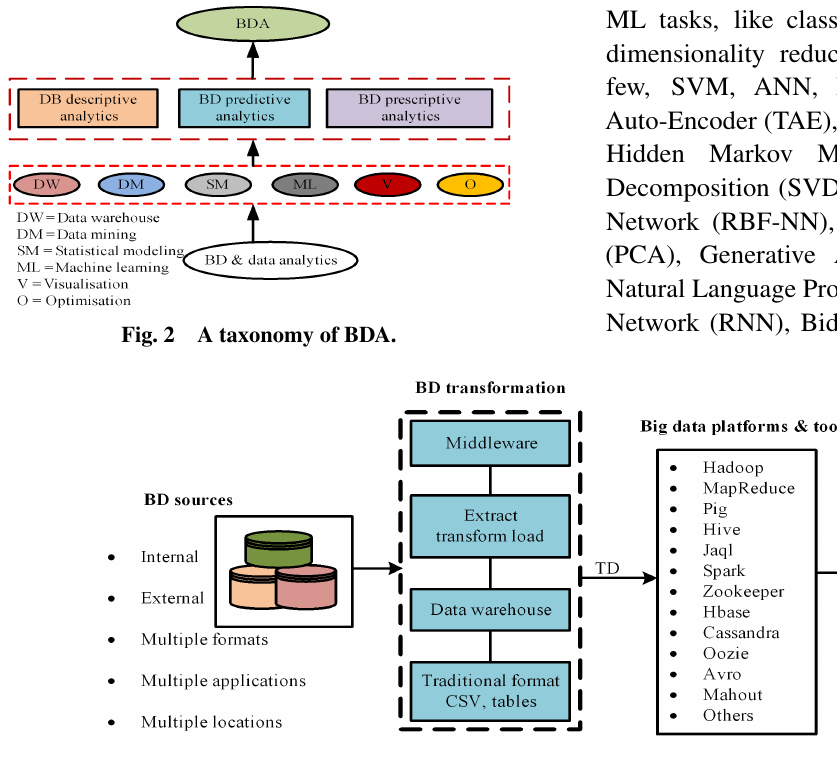
Fig. 3 A theoretical architecture of BDA. Here TD represents transformed